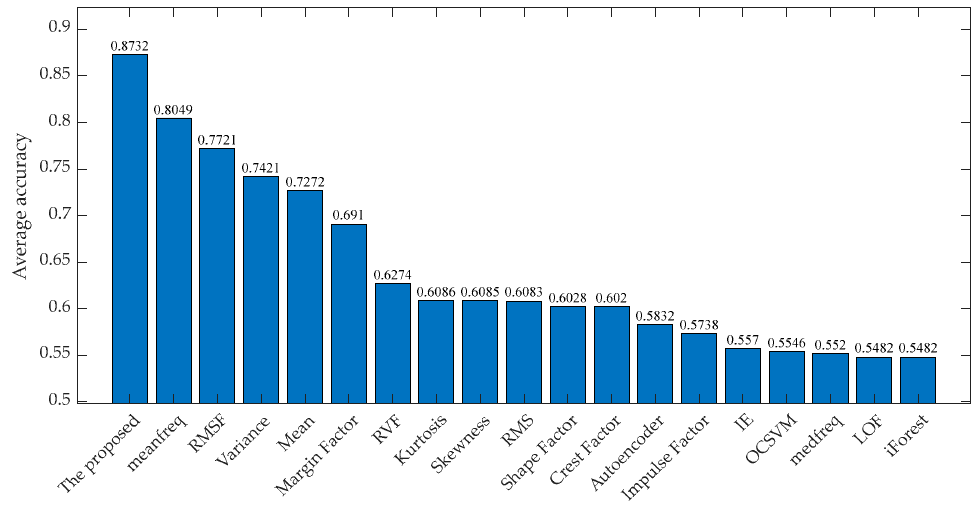
Figure 13. The average accuracy of the probed methods.